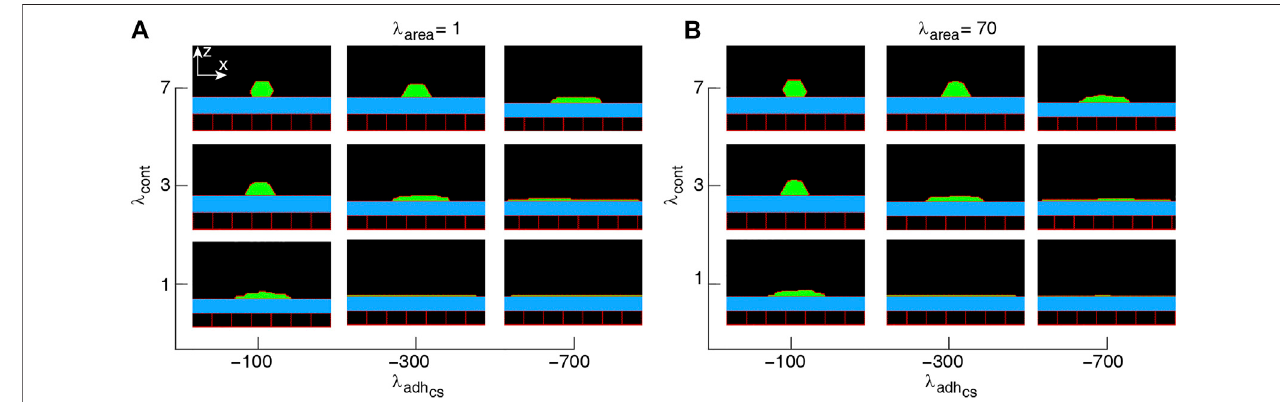
FIGURE1| Phasediagramofsingle-cell shapes (A,B) . x - z cross-section ofthecell(green)placed onasubstrate(blue)surrounded byanempty region(black) and wall cells (black squares). Simulations were run with the cell proliferation disabled. The range of parameter values are adopted from (Khataee et al., 2020). Snapshots were taken in the